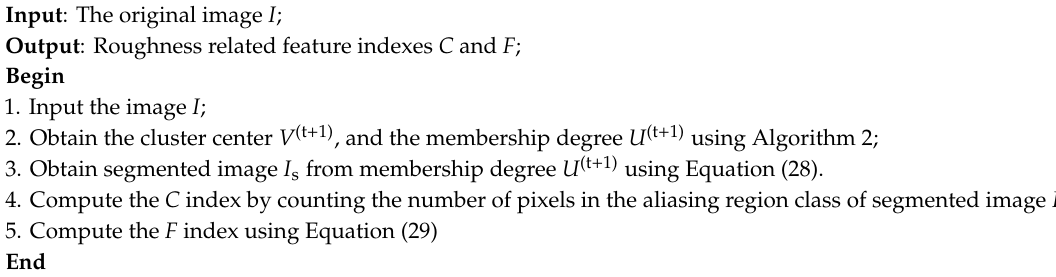
Algorithm 3 The process of roughness measurement method based on FCM_NNS